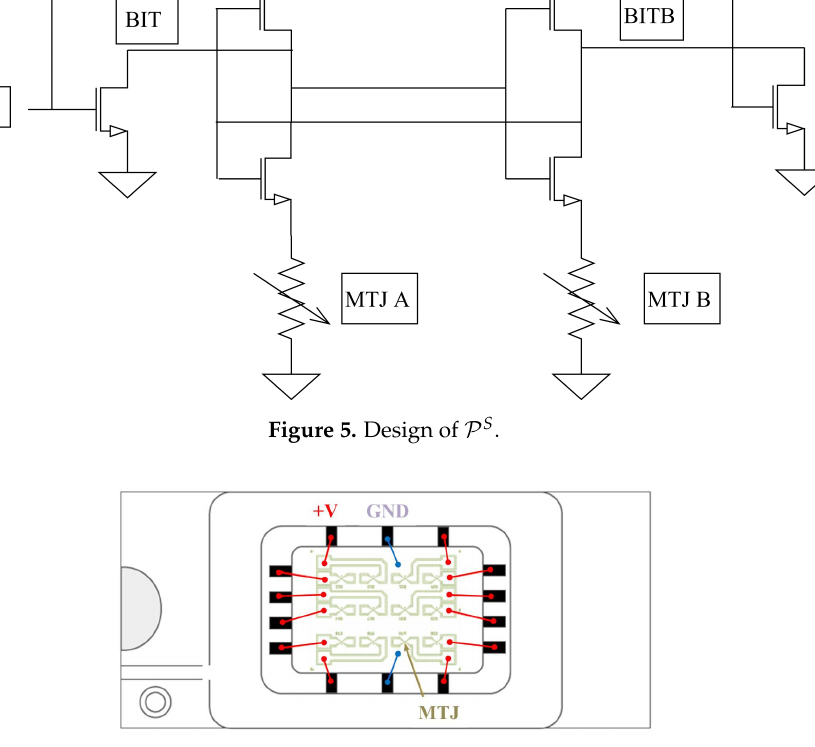
Figure 6. Dual in-line package of our